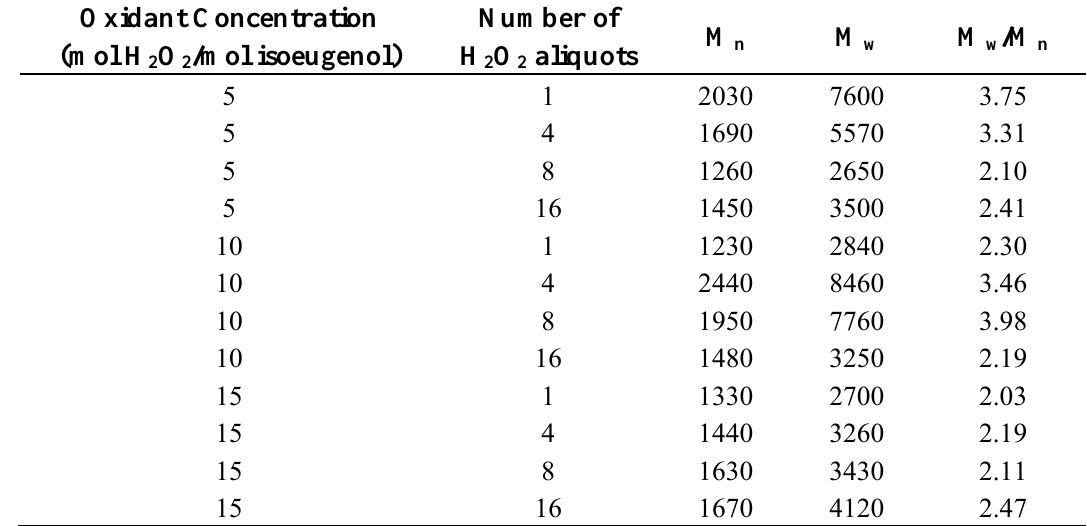
Table 5. Results of GPC analyses on coupling products of isoeugenol in the presence of CuSS as catalyst when the oxidant concentration and the oxidant addition rate were varied. Oxidant Concentration O /mol (mol H 2 2